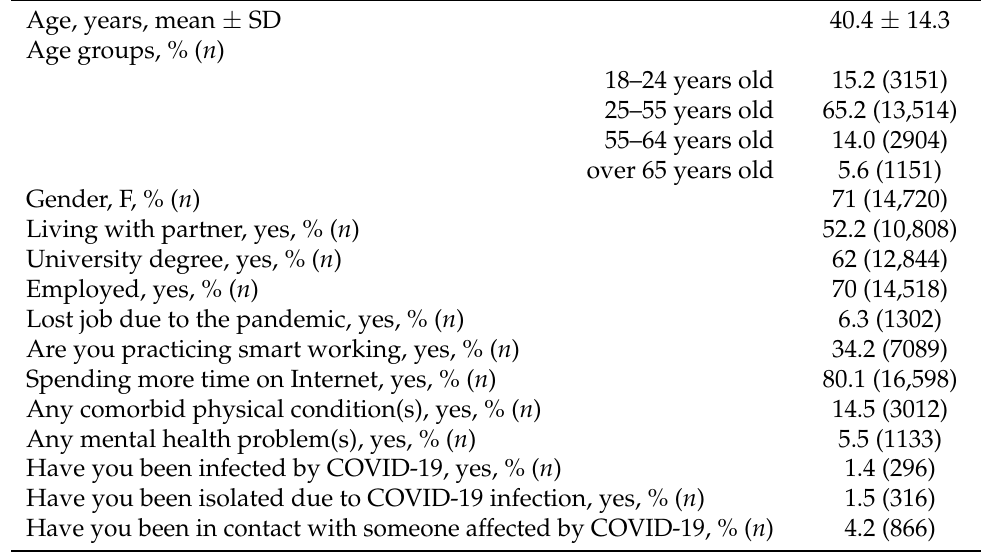
Table 1. Socio-demographic and clinical characteristics of the sample ( n = 20,720).